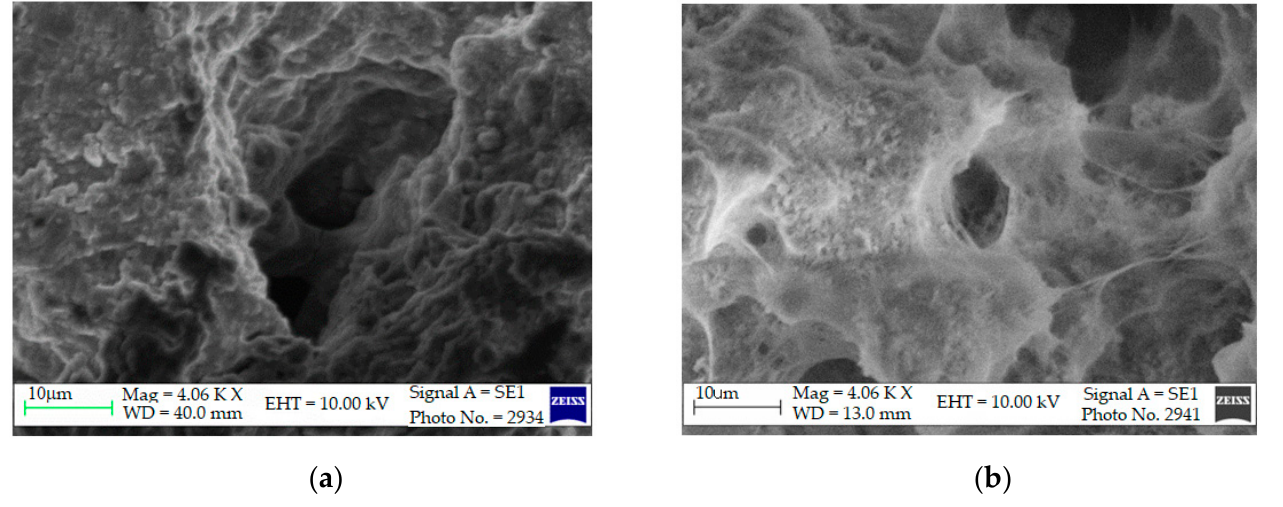
Figure 5. Micrographs attained by SEM with 1800× magnification for: ( a ) not calcined catalyst and ( b ) calcined catalyst.